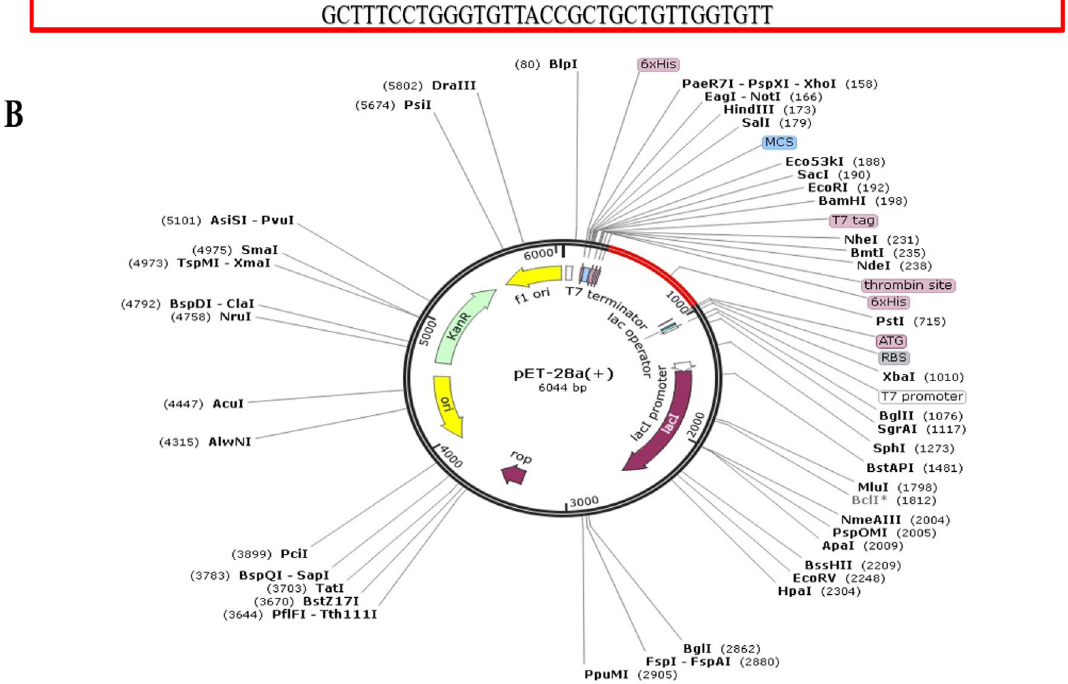
Figure 7. ( A ) The codon-optimized sequence of multi-epitope vaccine. ( B ) In silico cloning of polyepitope vaccine construct (shown in red) in pET28a expression